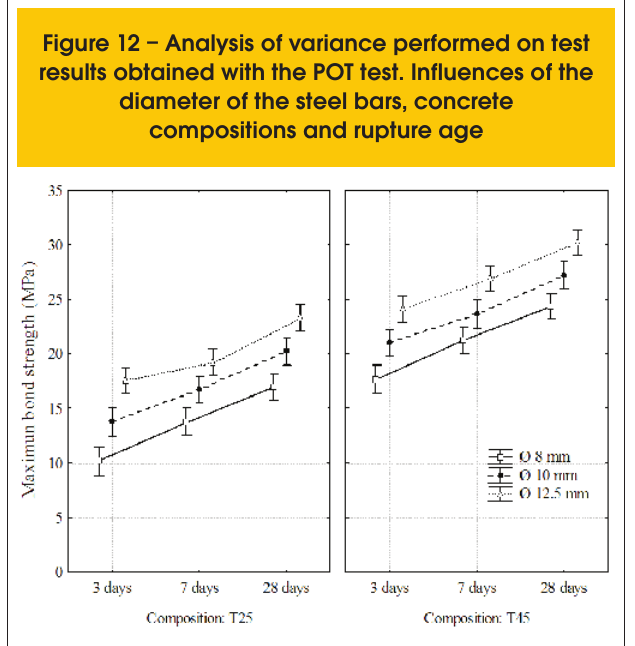
Figure 13 – Linear regressions of correlation between the maximum bond strength and compressive strength of the concrete, for each steel bar